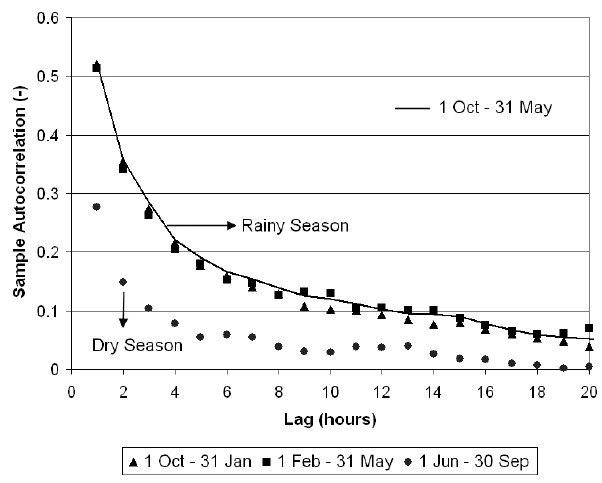
Fig. 2. Sample autocorrelograms referred to the Cosenza Rain-